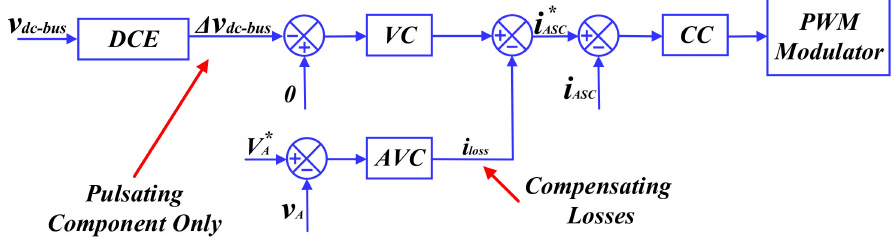
Figure 17. Control structure of controlled voltage source strategy based on plug-and-play